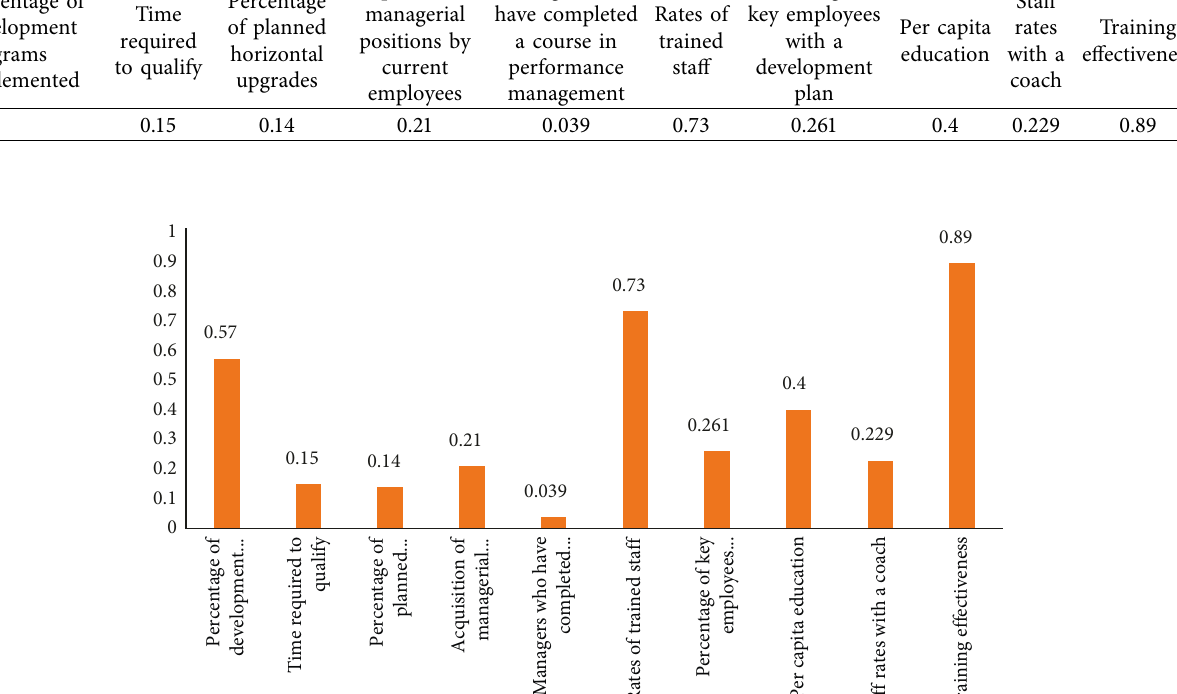
Table 13: Weights obtained from the hierarchical analysis process in terms of growth and learning. Percentage of